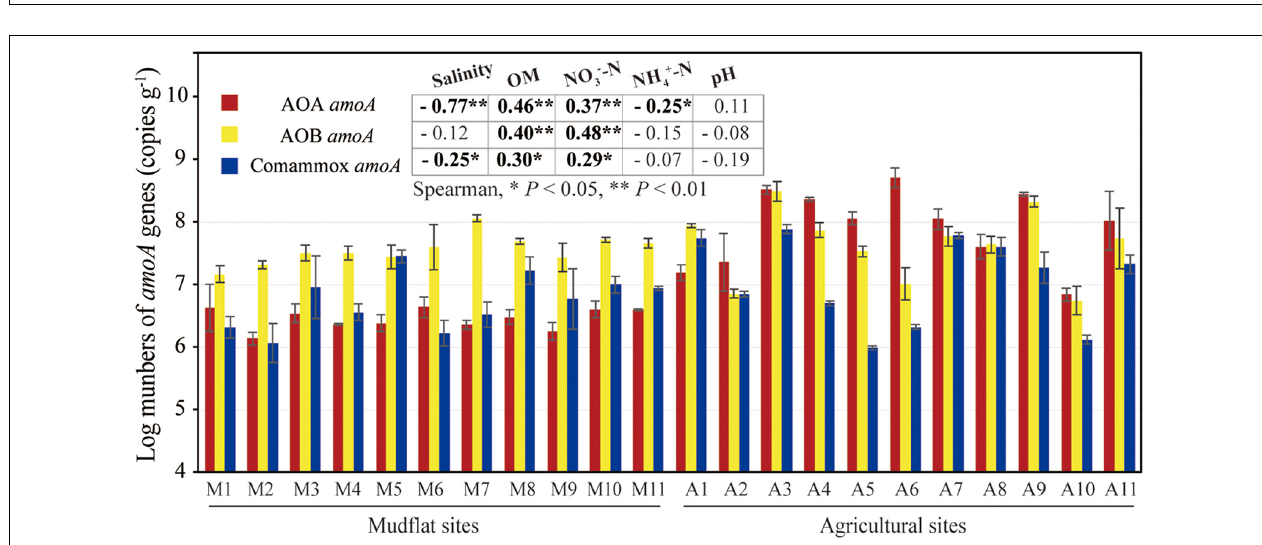
FIGURE 1 | Soil physiochemical properties of mudflat and agricultural soils.